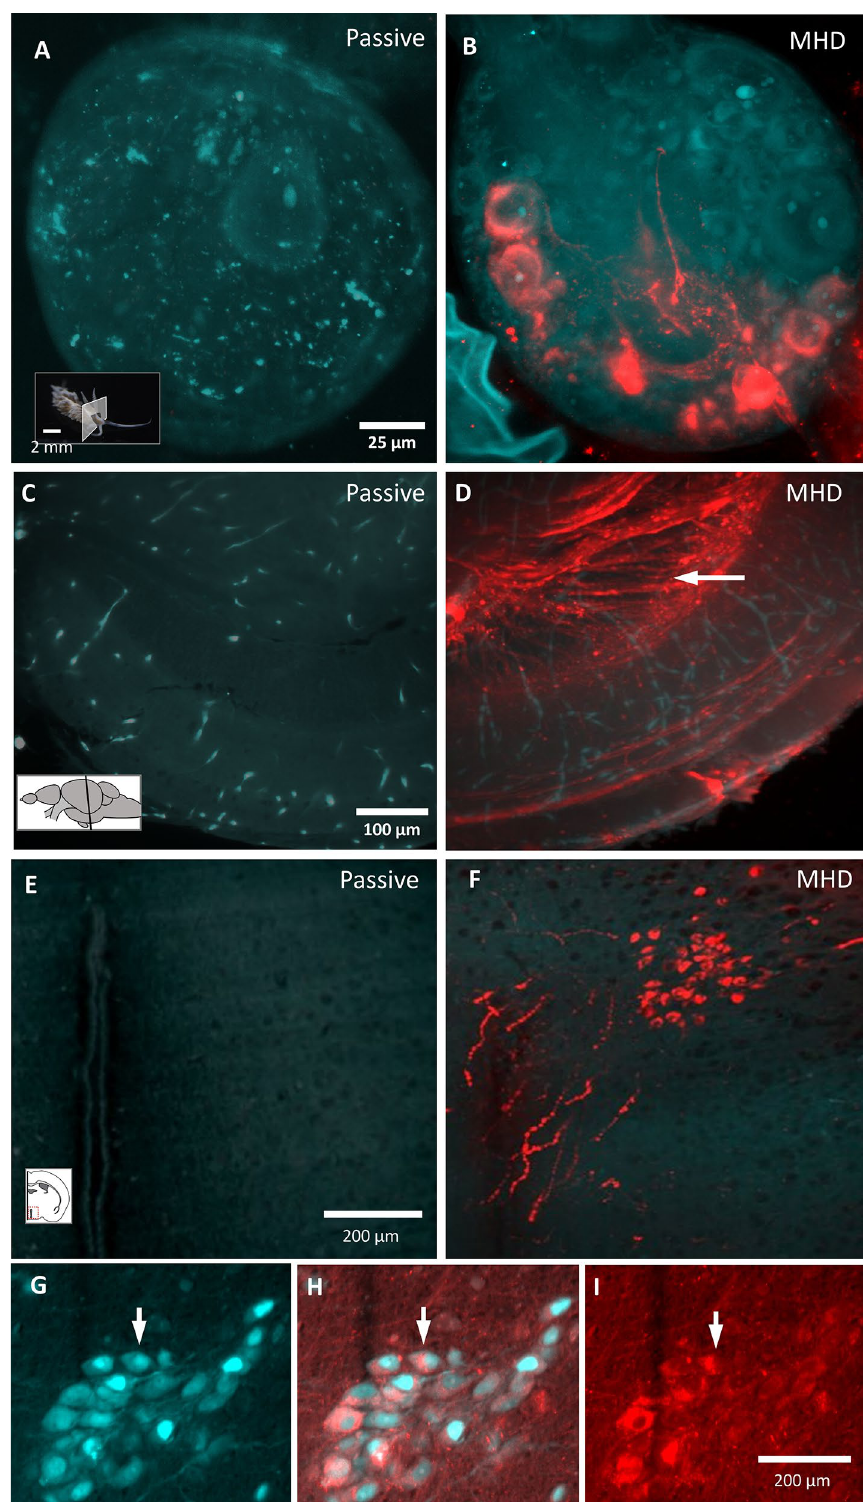
Figure 4. MHD-accelerated antibody labeling of brain tissue from sea slug, zebrafish, and mouse. ( A , B ) Image of an intact Berghia stephanieae pedal ganglion after passive (A) and MHD-accelerated ( B ) α-serotonin antibody labeling (red) with tissue autofluorescence (cyan). ( C , D ) Images of a cleared adult zebrafish brain (3 mm x 3 mm x 6 mm) after α-acetylated tubulin antibody labeling (red) with tissue autofluorescence (cyan; Passive labeling: C; MHD-accelerated labeling: D). ( E , F ) Images of cleared mouse brain sample (6 mm x 6 mm x 6 mm) after α-oxytocin labeling (red) with tissue autofluorescence (cyan; Passive labeling: E; MHD-accelerated labeling: F). ( G – I ) MHD-accelerated labeling of adult mouse brain sample (6 mm x 6 mm x 6 mm) after α-vasopressin antibody labeling (cyan) with genetically encoded tdTomato in vasopressin-expressing neurons (red; AVP-cre X rosa26-lsl-tdTomato; Pearson’s coefficient: r = 0.609). Insets indicate the imaging